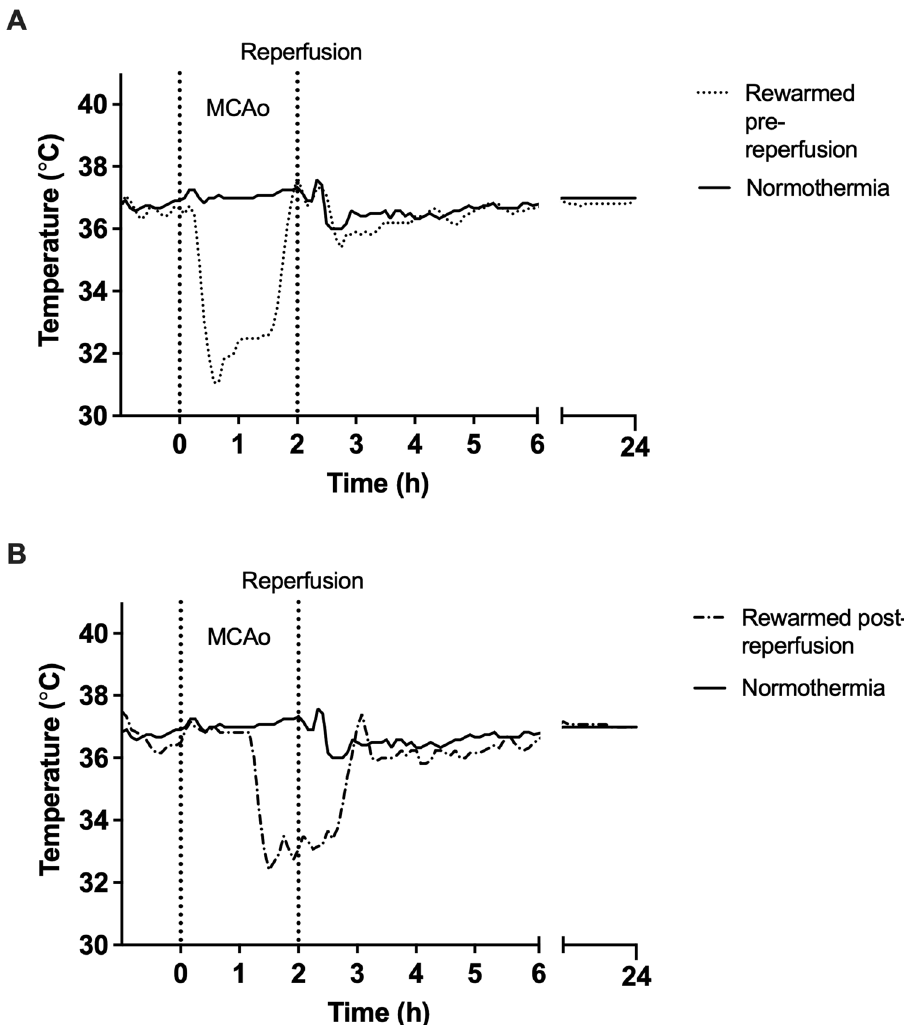
Figure 1. Core body temperature data. ( A ) rewarmed pre-reperfusion and normothermia. Hypothermia was initiated 15 min post-MCAo. After target temperature was reached, hypothermia was maintained for 1 h before rewarming, and prior to reperfusion at 2 h post-stroke. ( B ) rewarmed post-reperfusion and normothermia. Hypothermia was initiated 75 min post - MCAo. After target temperature was reached, hypothermia was maintained for 1 h before rewarming was initiated . Reperfusion had already occurred at the point of rewarming initiation in this